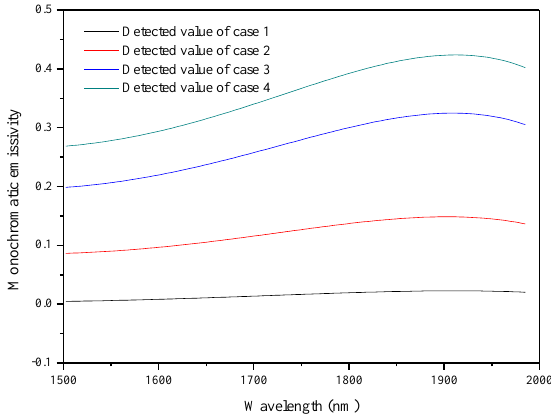
Figure 7. The detected monochromatic emissivity of four cases.